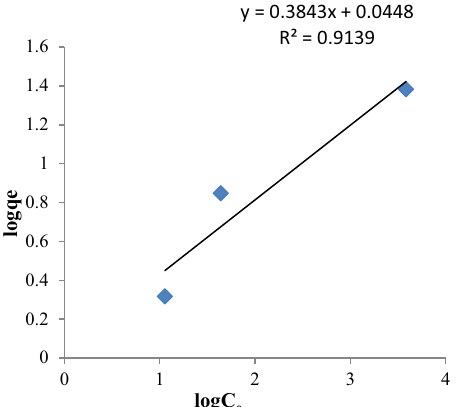
Fig. 6 Freundlich adsorption isotherm of Fe + 3 in case of A. niger as biomass. The isotherm was measured for initial values of iron (III) between 2.052 and 4811.98 mg/L, at room temperature, at optimum condition for the best adsorption (pH = 2.4, time of adsorption 60 min and for 4 g biomass).